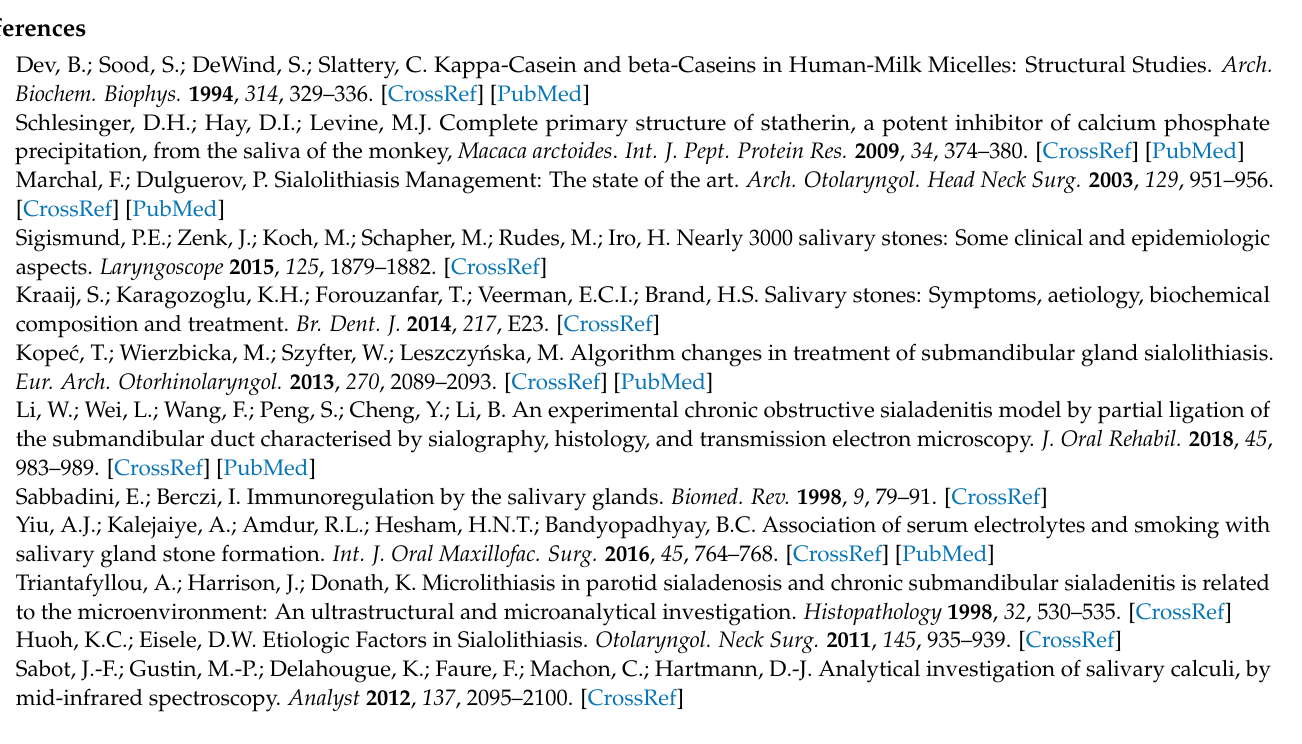
Table S2: SWATH-MS intensities after TAS normalization for all quantified proteins in individual and pool samples and the results of t-tests conducted for each individual sample compared with the pool